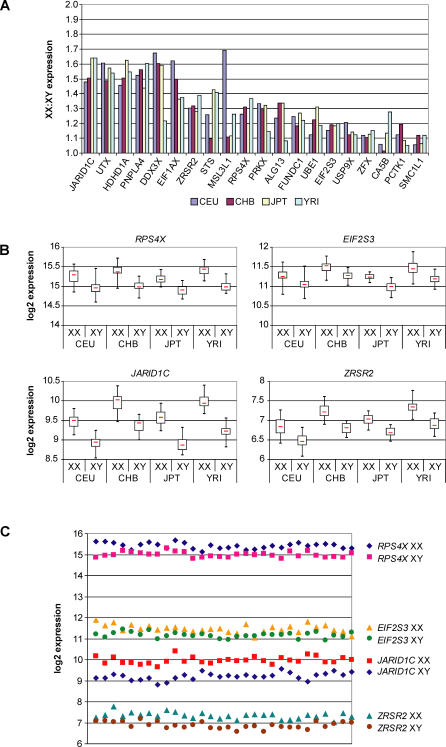
Comparison of Female and Male Expression of Genes with Higher Female Expression(A) Female to male expression ratio for 20 genes expressed more highly in females in four human populations. Expression in females is typically 10%–50% higher than in males.(B) Box and whisker plots showing the median, distribution, and range of expression for females and males for four X chromosome genes with higher female expression. The median is indicated by the red line, the box shows the interquartile range, and the ends of the whiskers the maxima and minima. The y-axis spans a 4-fold range for each graph to enable direct comparison of different genes.(C) Scatter plot of expression values of four non-dosage compensated genes in 30 males and 30 females from the YRI population. JARID1C is unique as none of the males has higher expression than any of the females. For EIF2S3 the overlap is considerable, as only half the females have higher expression than the highest male and only five males express at a level below the lowest female.